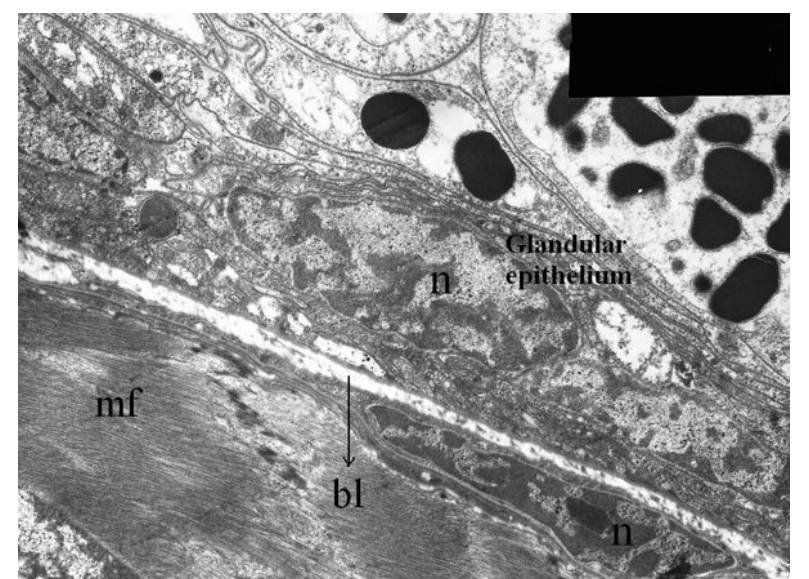
Figure 4. The muscle layer and glandular epithelium are separated by basal lamina (bl). Secretory cells present a nucleus (n) placed close to their basal portion, while the nucleus of the muscle cells are peripheral